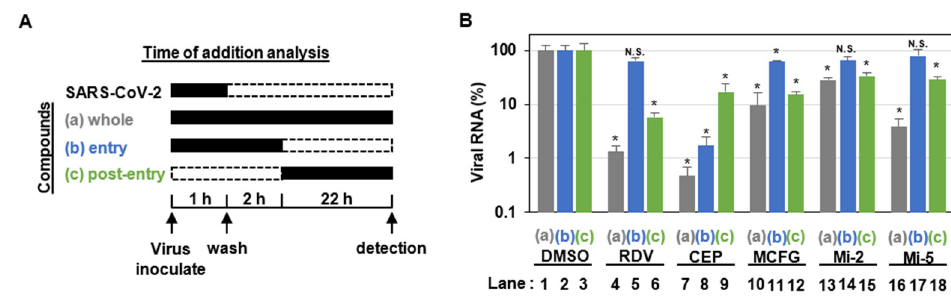
Figure 1. MCFG and its derivatives inhibited the post-entry process of SARS-CoV-2. ( A ) Schematic representation of the time-of-addition analysis. Compounds were added at three different times: ( a ) whole: throughout the assay for 25 h, ( b ) entry: for the initial 3 h to evaluate the effect on the viral